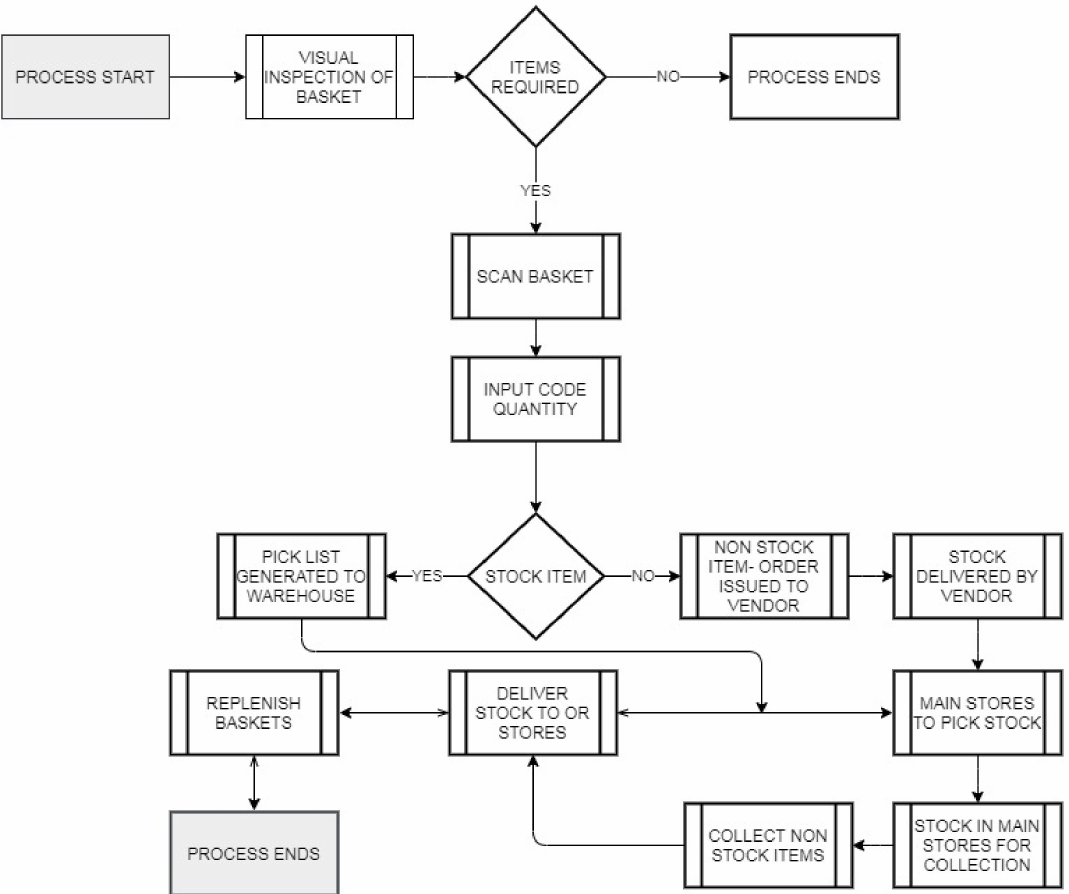
Figure 2. Procurement OR Staff Process Flow Map for Stock